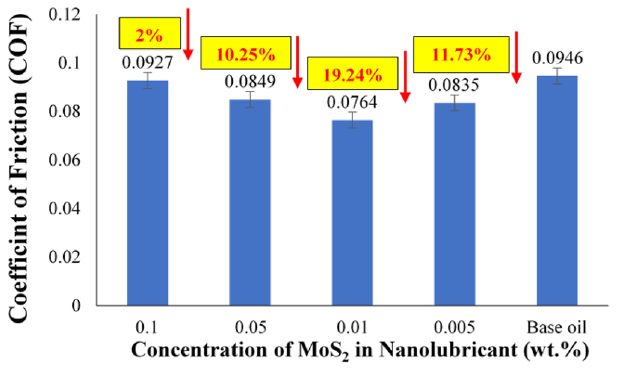
Figure 6. COF of MoS 2